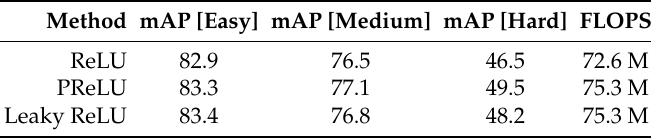
Table 4. Comparisons between different activation functions.